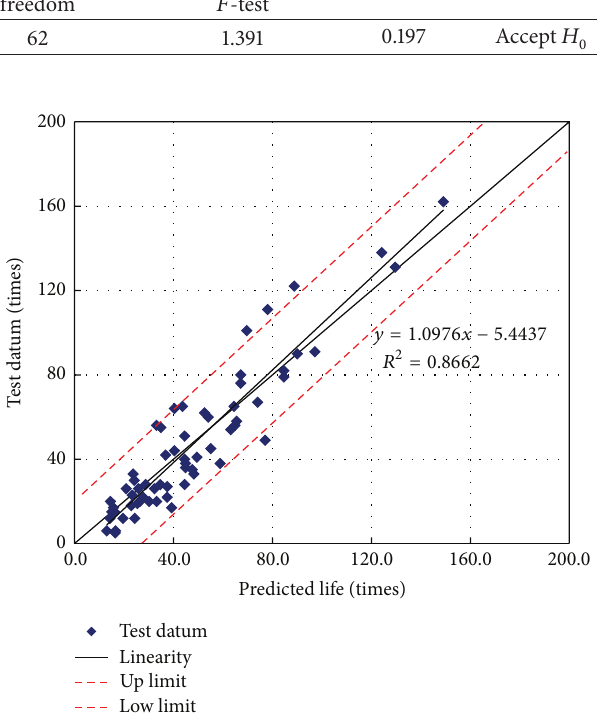
Figure 5: Experimental and predicted adhesion fatigue lives for basalt and different